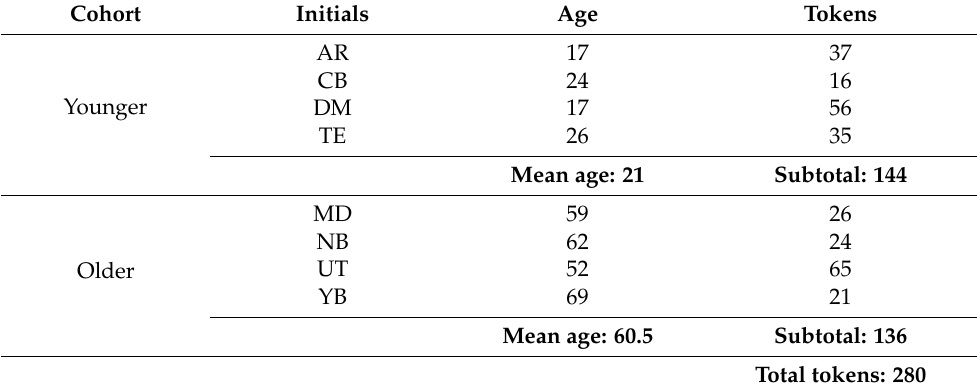
Table 3. Overview of speaker age and number of tokens within the Younger and Older cohorts. Cohort Initials Age